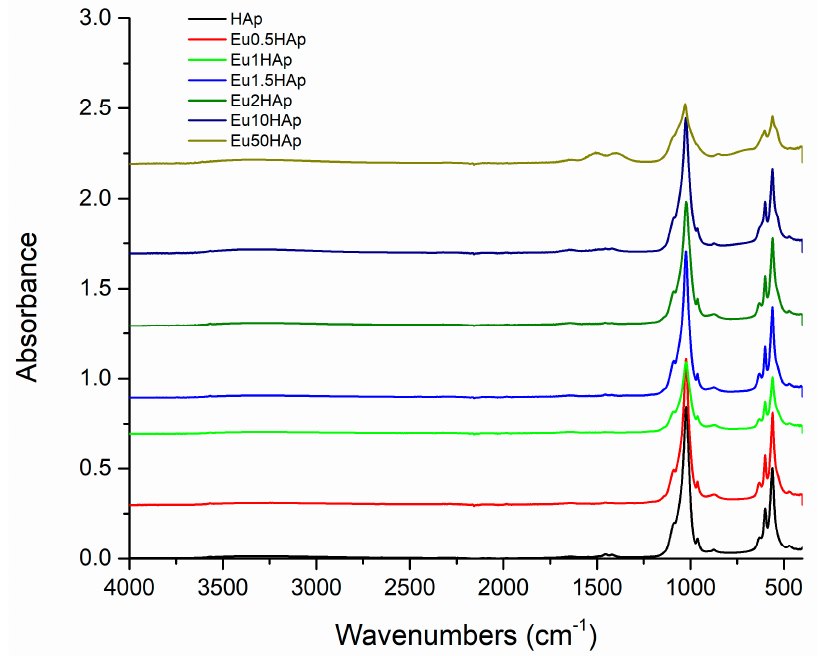
Figure 6. FTIR spectra of Eu X HAp samples.